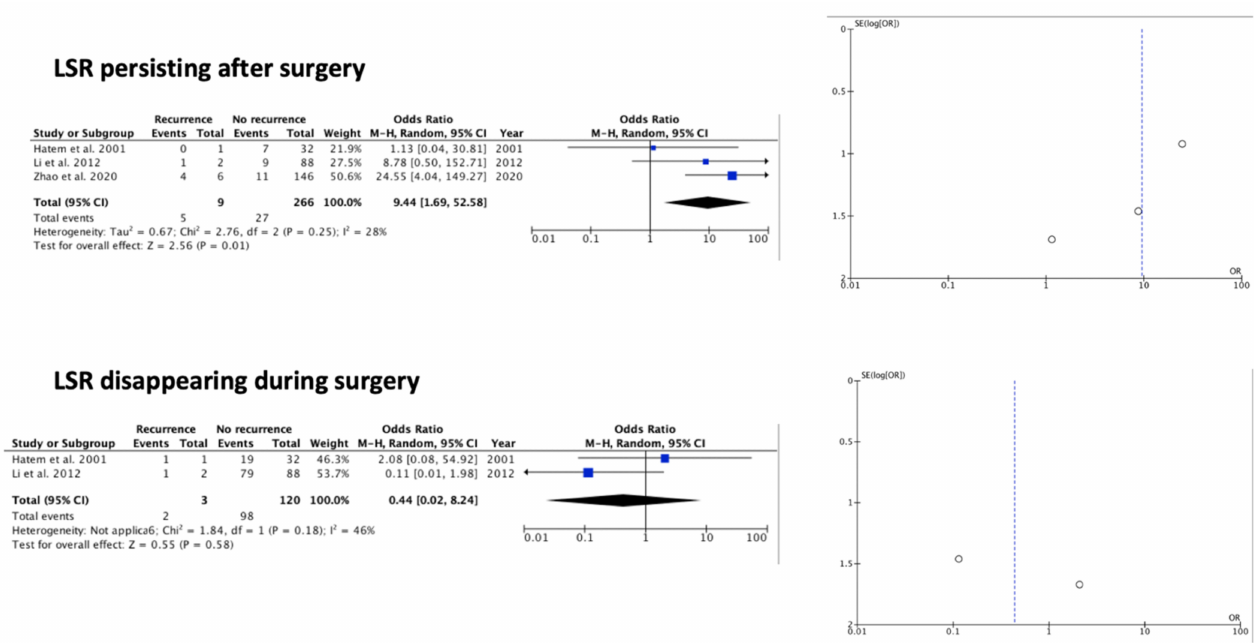
Figure 4. Forest plots and funnel plots for investigated intraoperative neurophysiological data. LSR (lateral spread response)